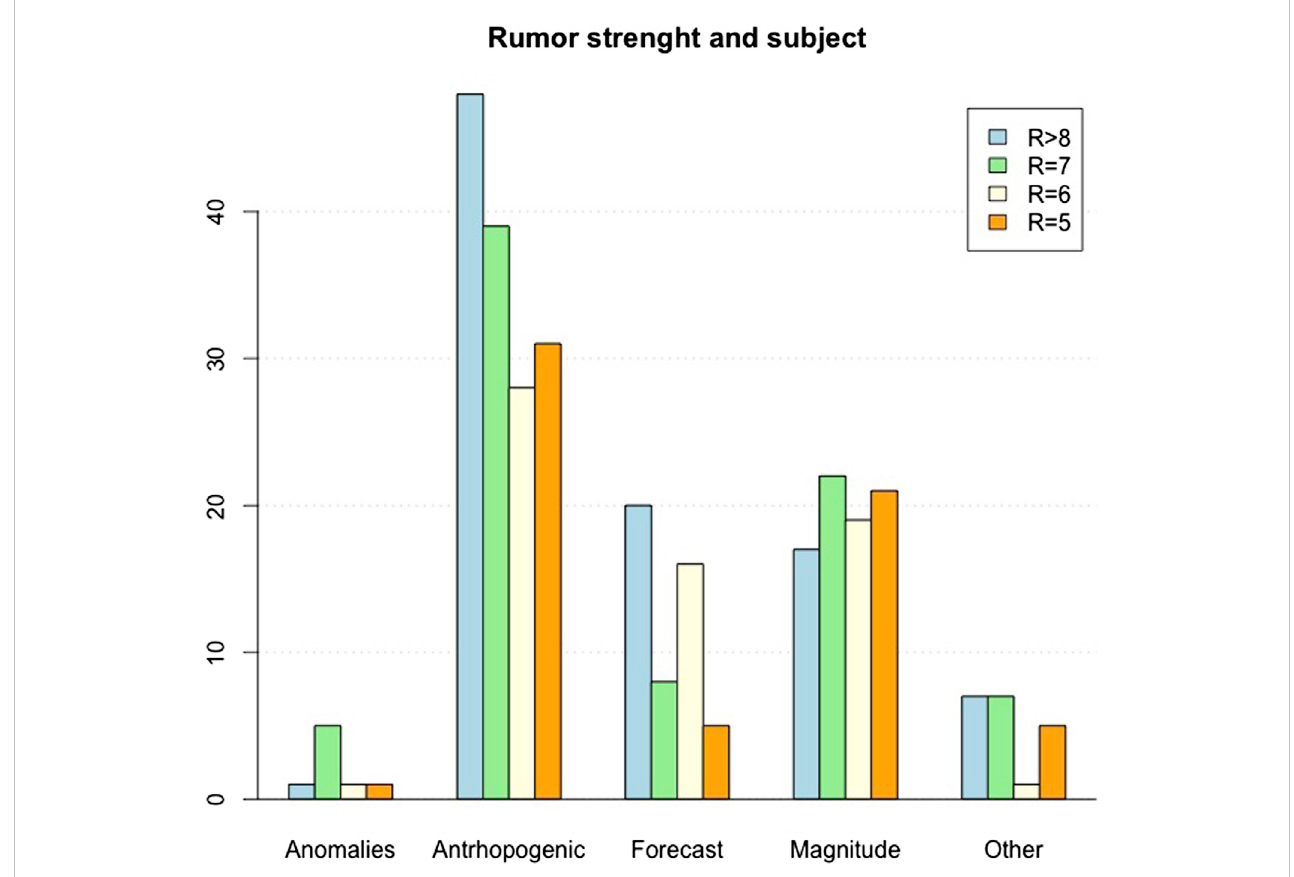
Distribution of rumors by strength and subject. Most of the rumors revolve around the anthropic nature (146 rumor reports, with an average strength of 7.0) and the supposedly hidden magnitude of the earthquakes (79 rumor reports, with average strength 6.7). Other rumors forecast future events (49 reports, averagestrength7.3)orreporttheoccurrenceofanomalousphenomena,possiblyrelatedwiththeseismicsequence(8reports,averagestrength6.9).Twenty other rumors regard other topics (average strength